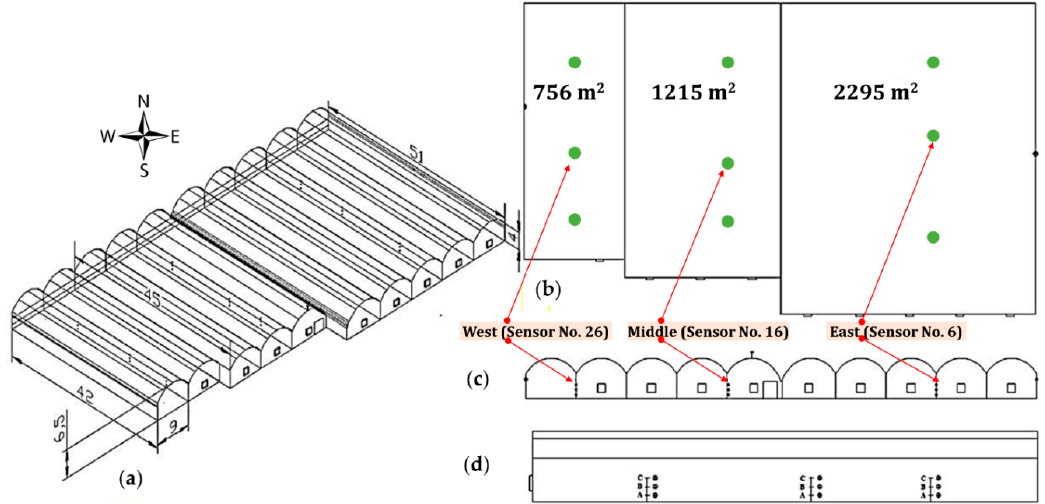
Figure 2. Schematic view of the greenhouse layout and the locations of wireless sensors: ( a ) perspective view of the greenhouse spans; ( b ) top view of the greenhouse spans with the green circles showing sensors locations; ( c ) front view of the greenhouse with sensors displayed by black dots; ( d ) right view of the greenhouse showing sensors at positions A = 0.60 m, B = 1.40 m, C = 2.20 m above the ground.